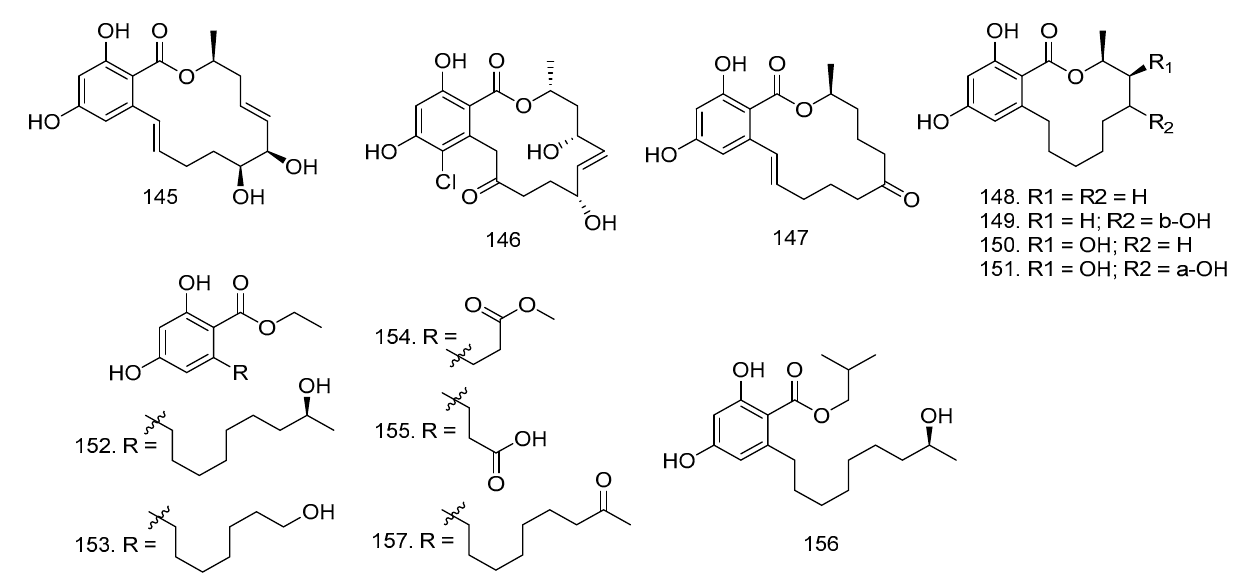
Figure 8. Compounds of resorcylic acid derivatives isolated from Endophytic fungi in